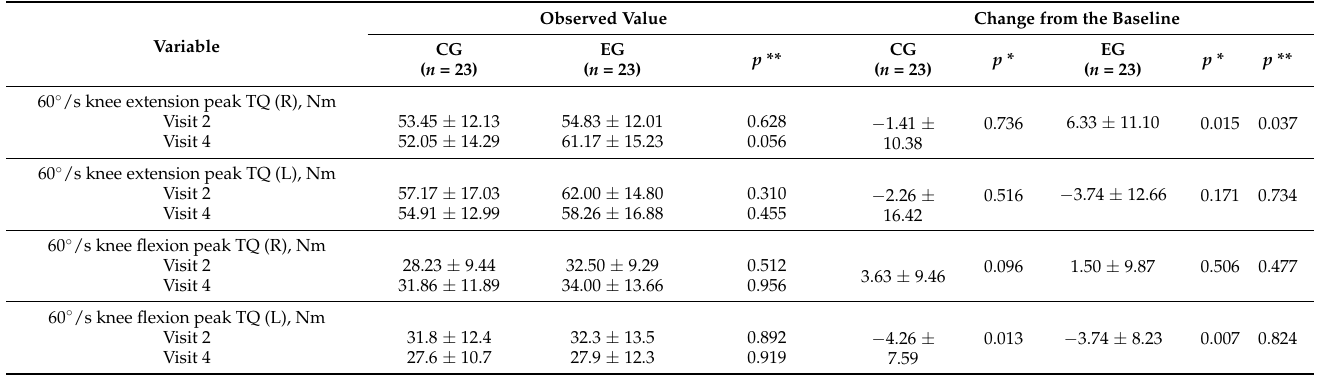
Table 3. Primary outcome comparisons between and within each group (PP population).